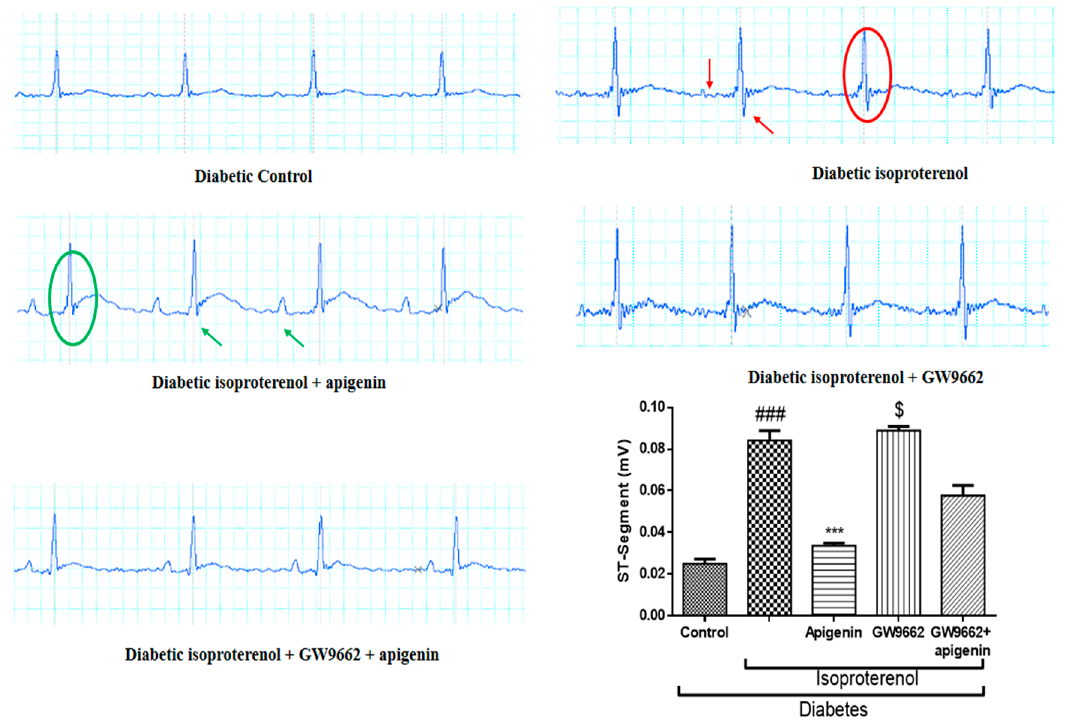
Figure 1. Effect of apigenin on electrocardiogram (ECG) wave forms in streptozotocin (STZ)–isoproterenol-treated rats. The red arrows indicate the deformations of normal ECG waveforms at the place of formation of P-wave and red circle indicates the changes in the QRS complex, especially the ST segment. The green circle indicates the normalization of ECG waveforms and restoration of the ST segment, while the green arrows indicate the normal appearance of the ST segment and P-wave. *** p < 0.001 compared to diabetic isoproterenol; ### p < 0.001 compared to diabetic control; $ p < 0.001 compared to diabetic isoproterenol + apigenin.